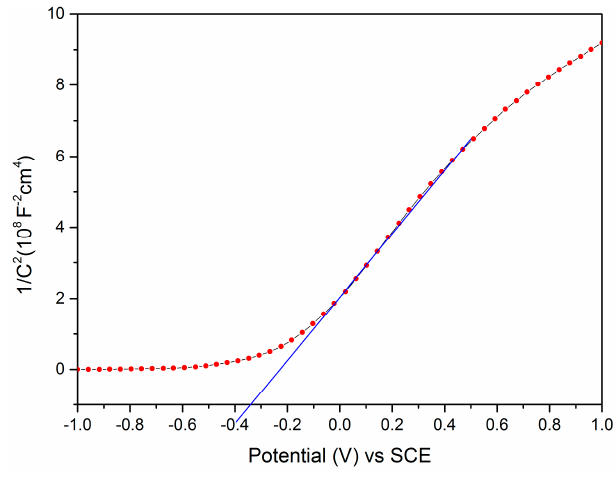
Figure 11. Mott ‐ Scho tt ky analysis of Ti foil at a potential range of − 1 to +1 V SCE . Figure 11. Mott-Schottky analysis of Ti foil at a potential range of − 1 to +1 V